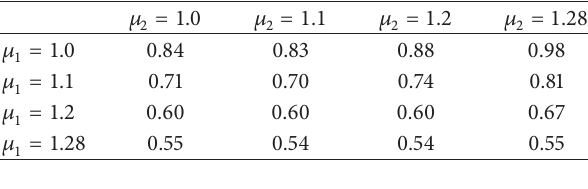
Table 1: The allowable minimum 𝛼 for different pair ( 𝜇 1 , 𝜇 2 ).